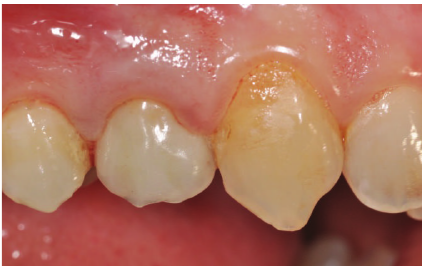
Figure 1: Vestibular view of the prosthetic crown on the upper right first premolar.